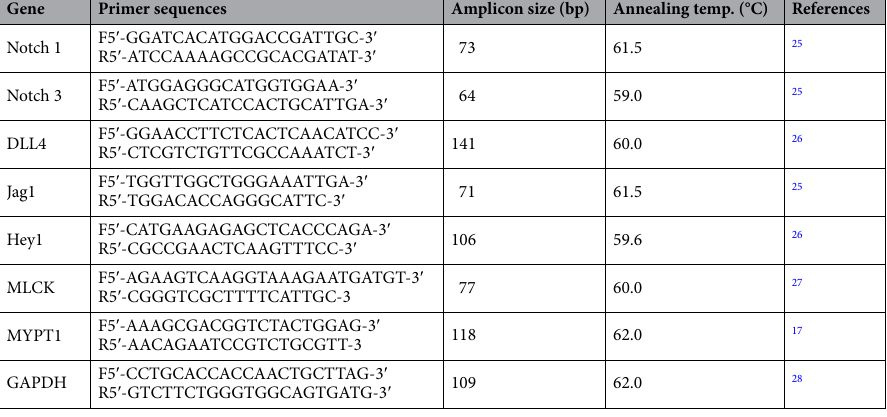
Table 1. Description of